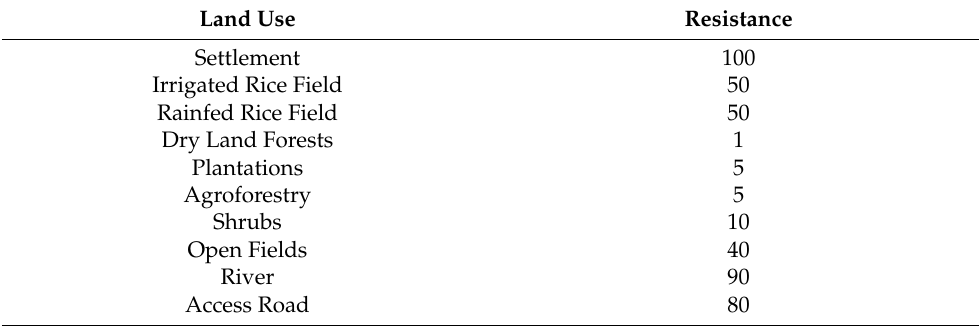
Table 2. The resistance values for land uses. Land